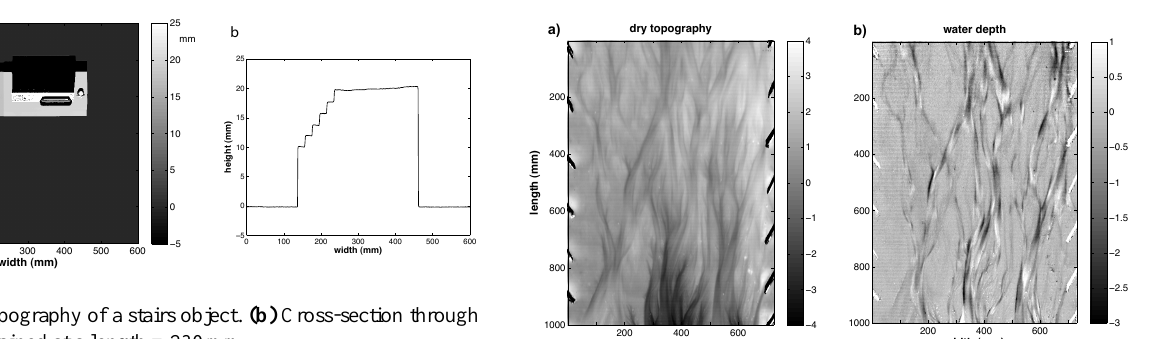
Fig. 5. (a) Topography of a stairs object. (b) Cross-section through the object obtained at a length = 230mm.